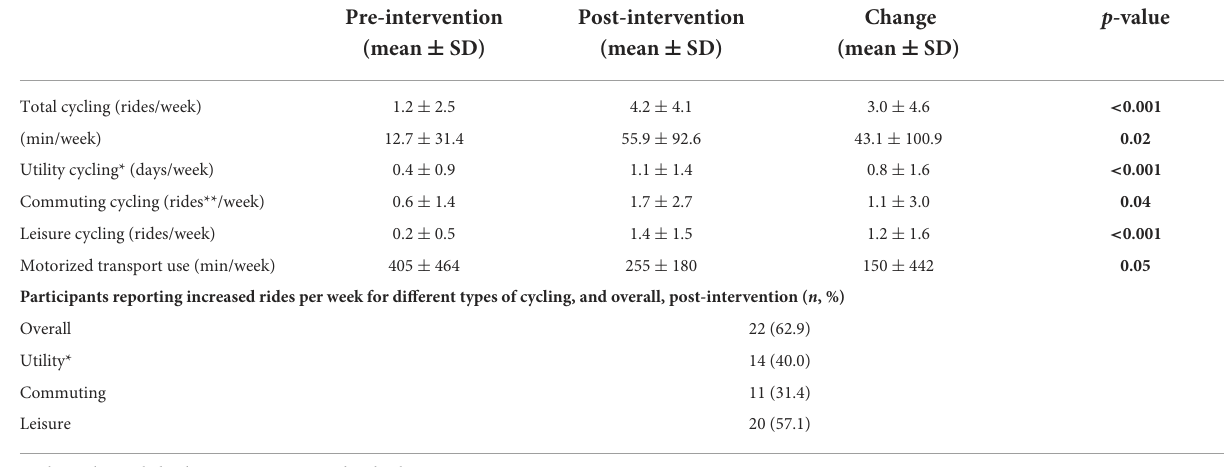
TABLE 6 Post-intervention changes in cycling and motorized transport (Edinburgh and London sites, all n = 35).